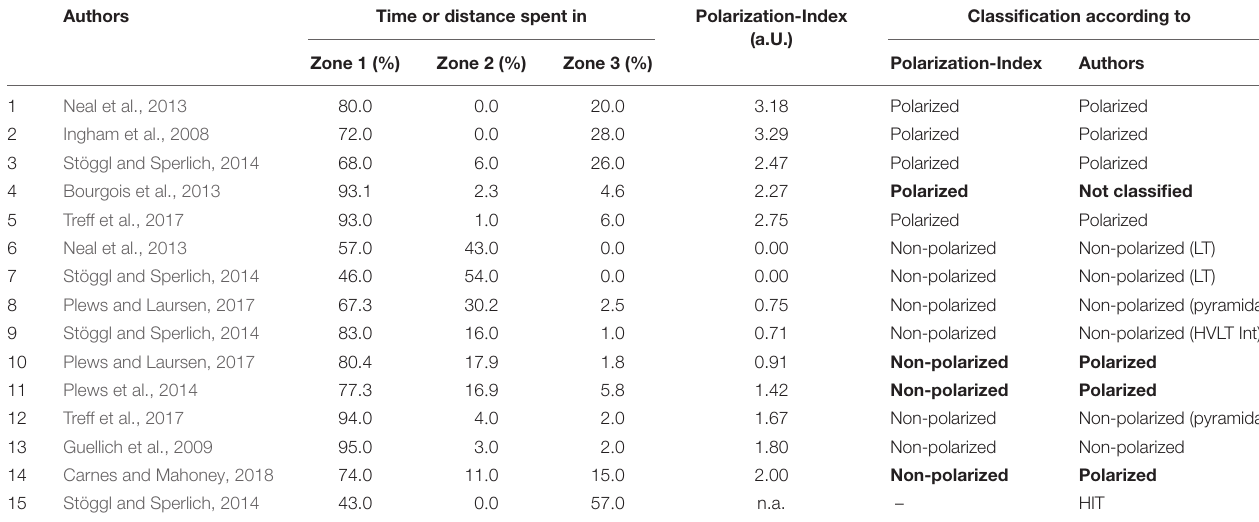
TABLE 1 | Selected studies in the area training intensity distribution, percentages of three training intensity zones, the resulting polarization-index, and their classification according to the polarization-index and the original publication. Authors